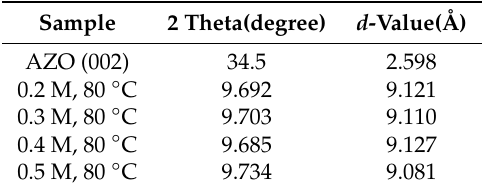
Table 2. d -values of each sample calculated by the XRD result.